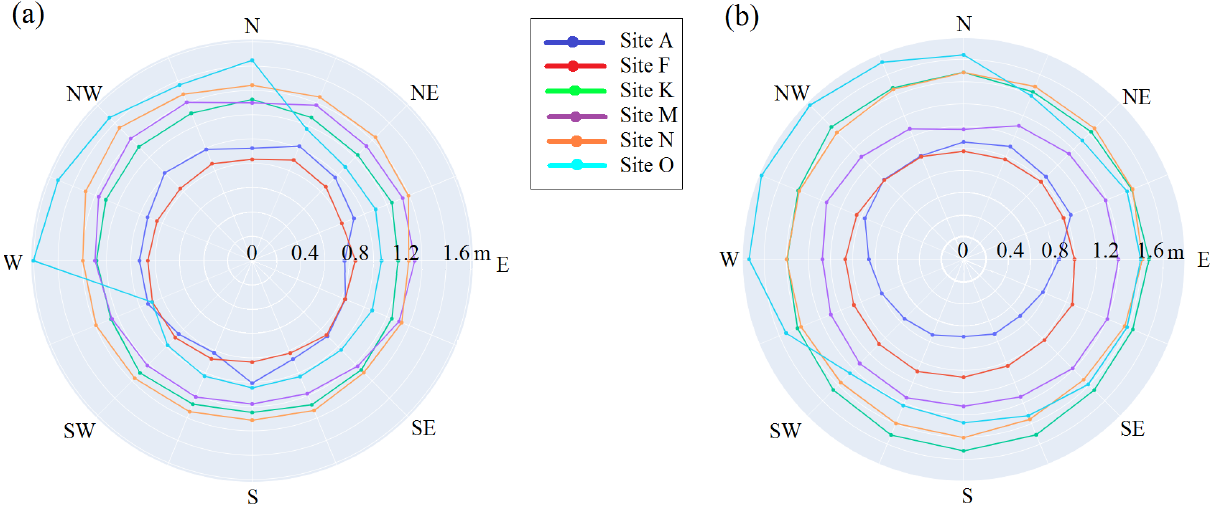
ing snow depth trend by moving farther from tree